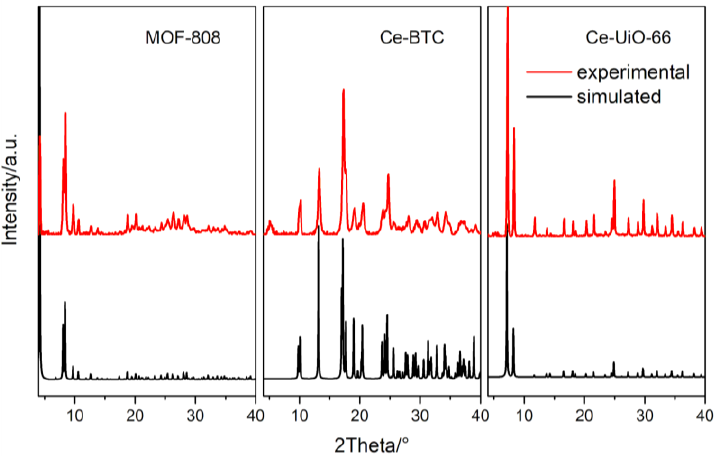
Figure 2. The PXRD patterns for the Ce-MOFs.